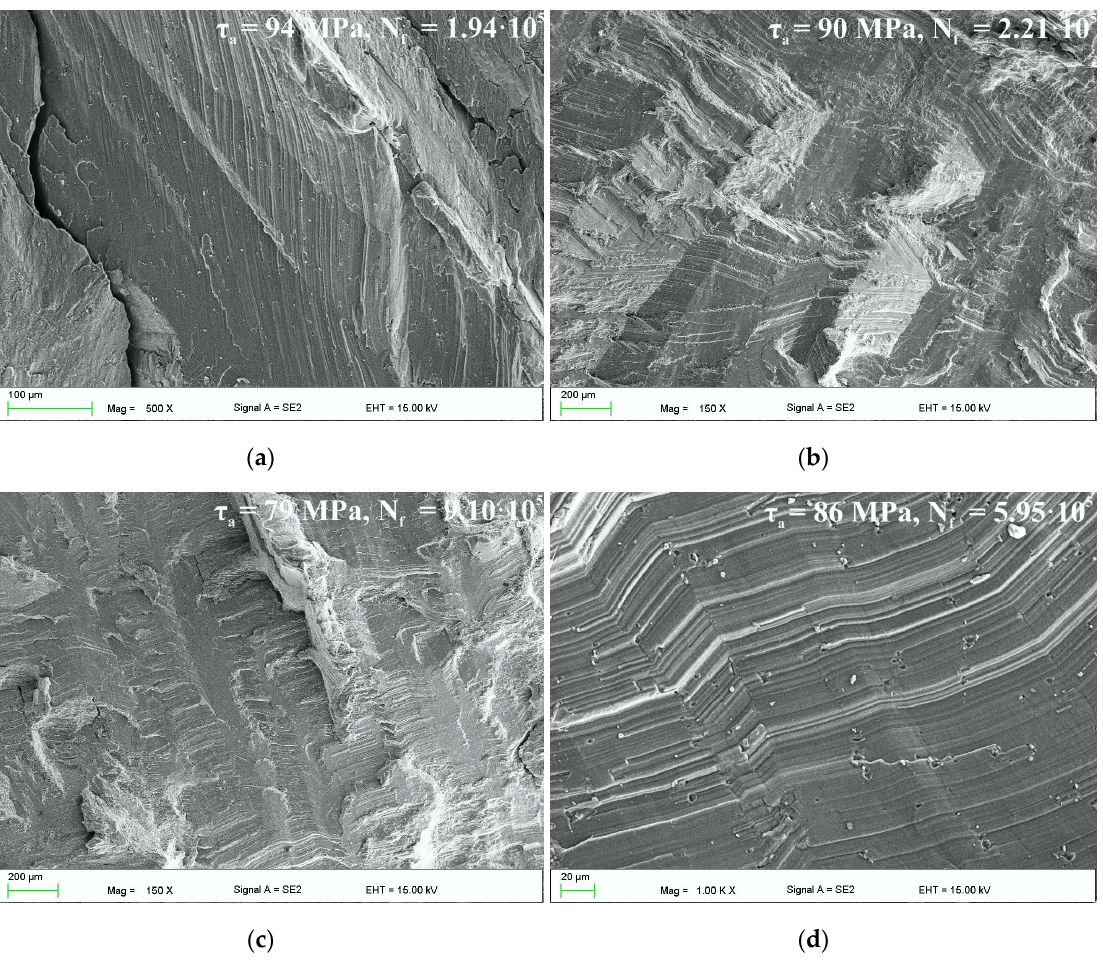
Figure 9. Fractures of fatigue test samples (double-sided torsion) of AlZn6Mg0.8Zr alloy, subjected to supersaturation in water from 500 °C: ( a ) secondary fatigue cracks along slip bands; ( b ) jogs of differently oriented fatigue crack planes; ( c ) jogs systems of cleavage planes; ( d ) parallel slip bands on the cleavage planes.